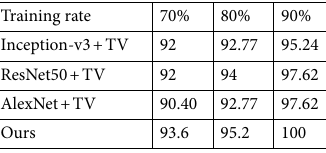
Table 7. The CA of the individual DL CNN models and the proposed one.